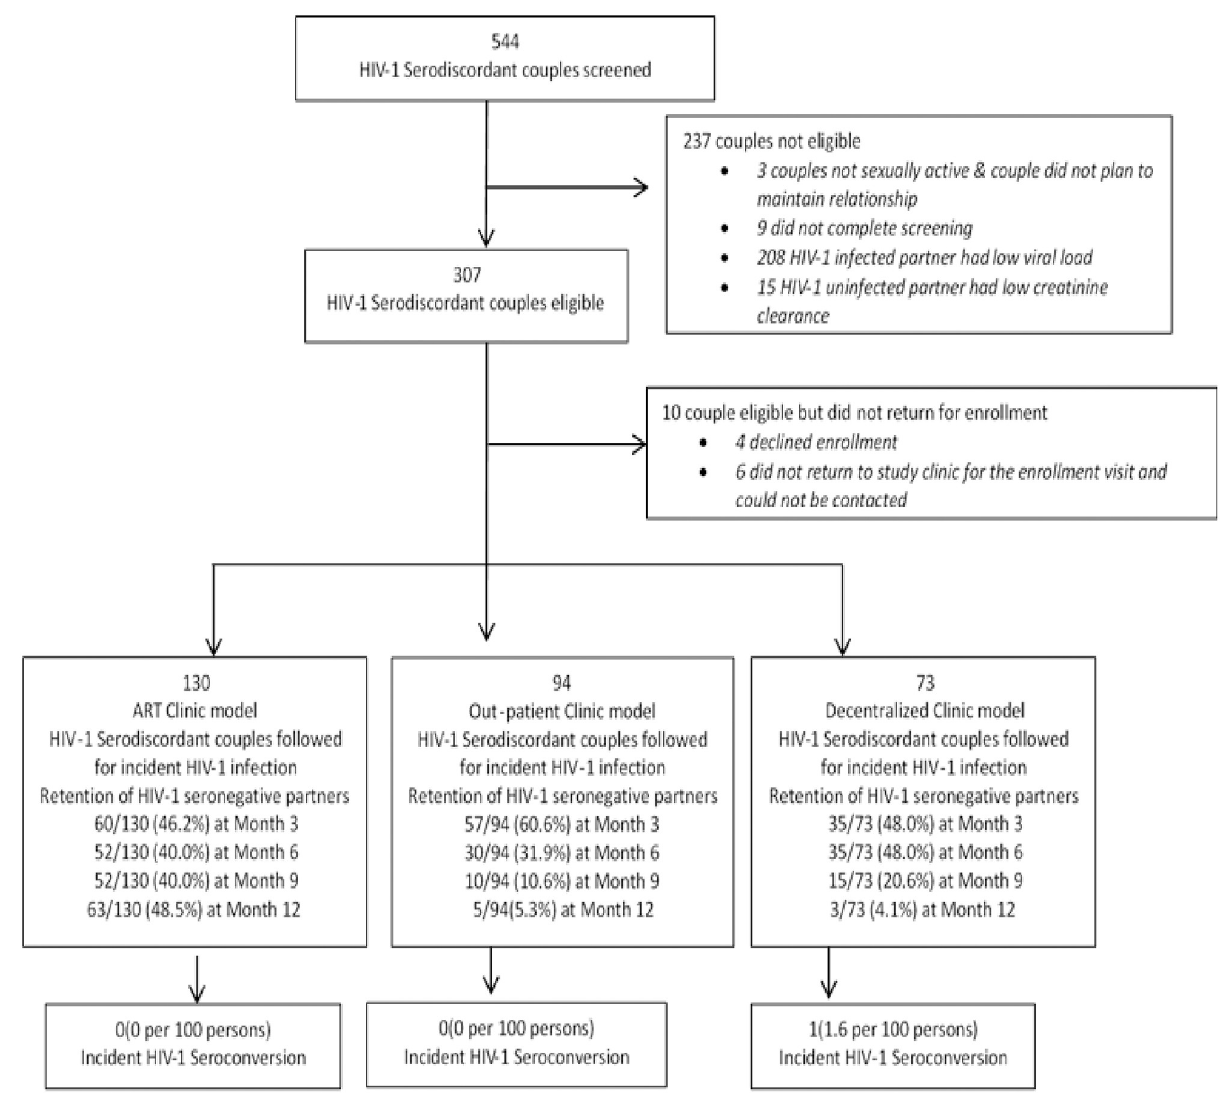
Fig 1. Screening, enrollment and follow up flow